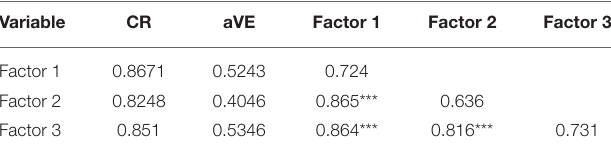
TABLE 5 | First-order convergence validity and discriminant validity table of the Gaming Hazard Assessment Scale (sample 2, n = 274).